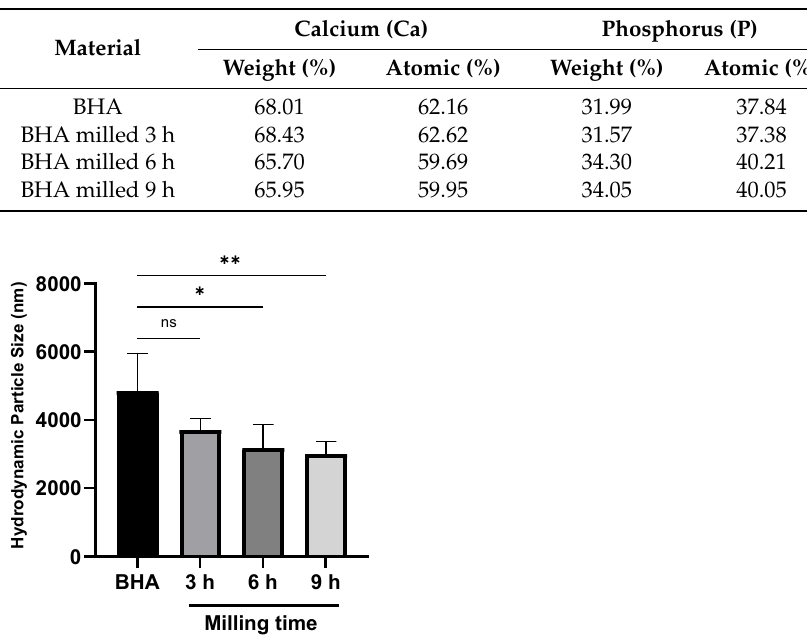
Figure 4. XRD spectra of unmilled and milled BHA. Table 1. Ca/P ratio of unmilled and milled BHA.